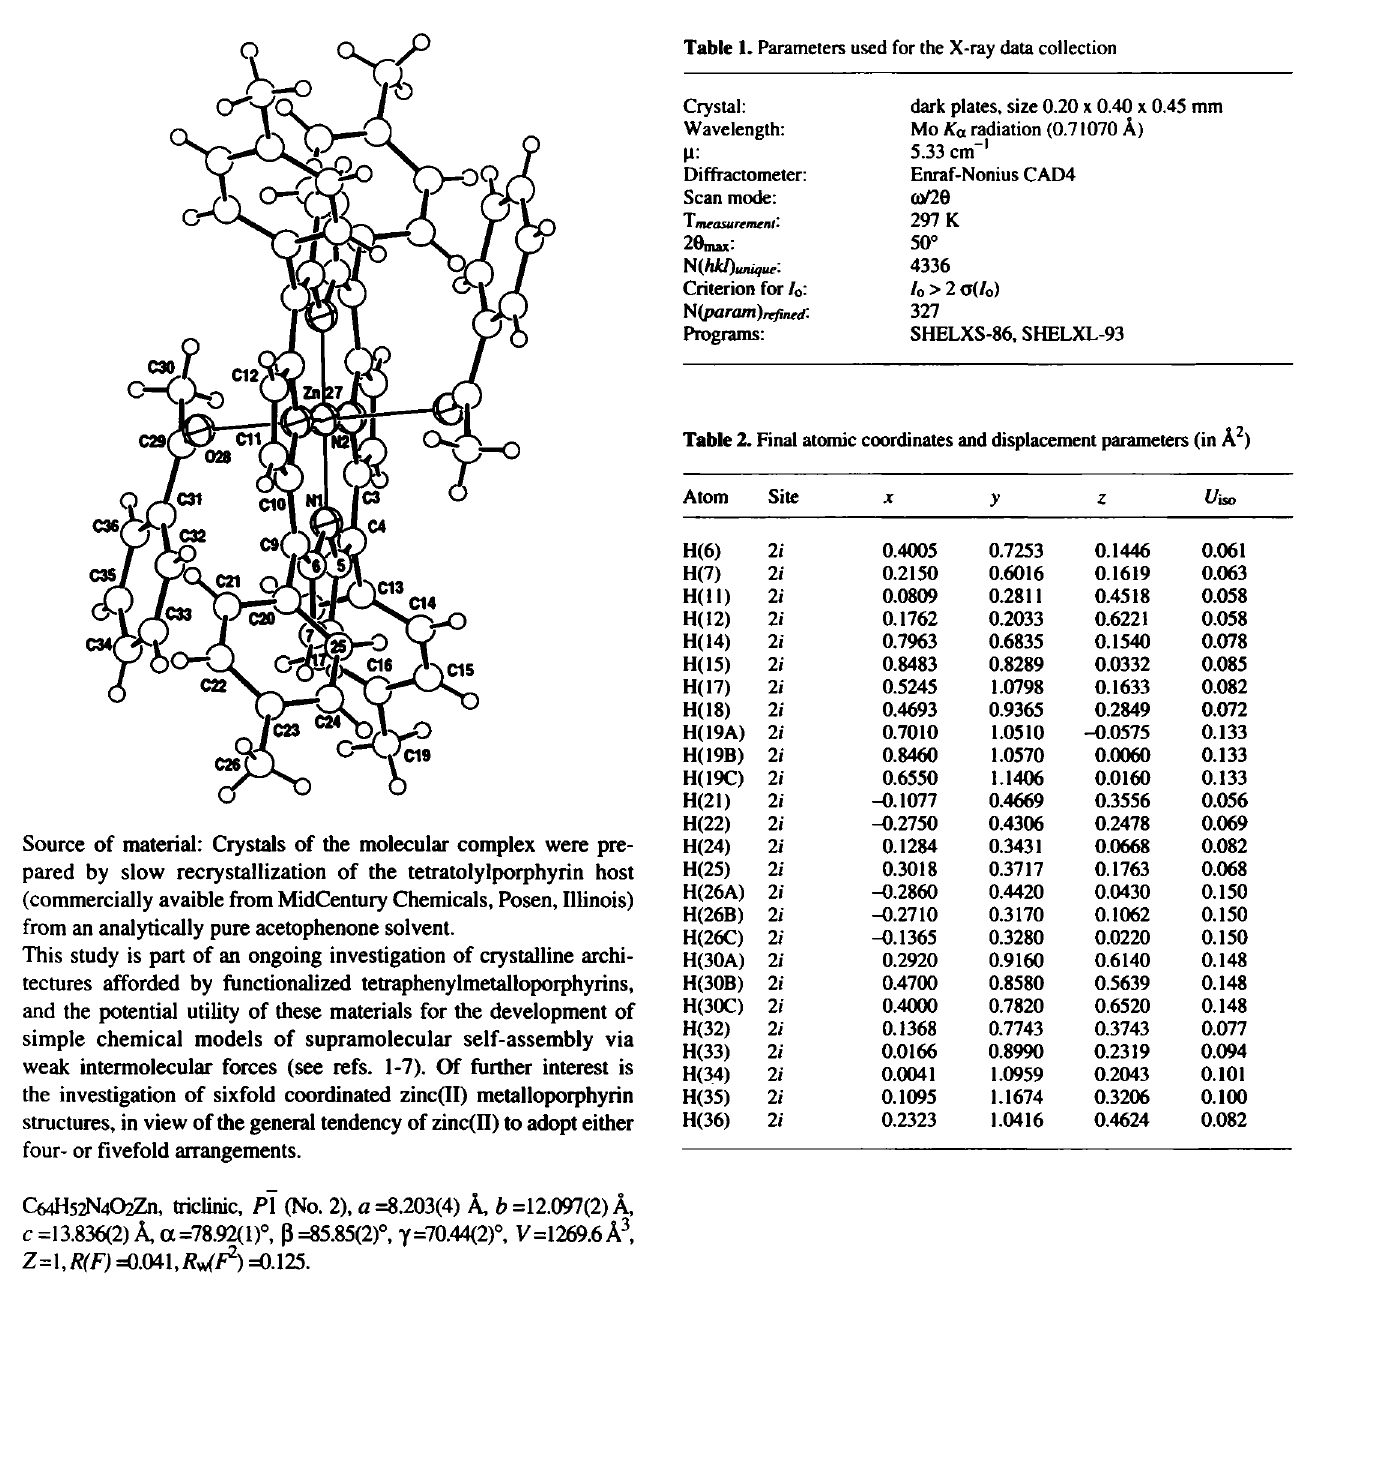
Table 1. Parameters used for the X-ray data collection